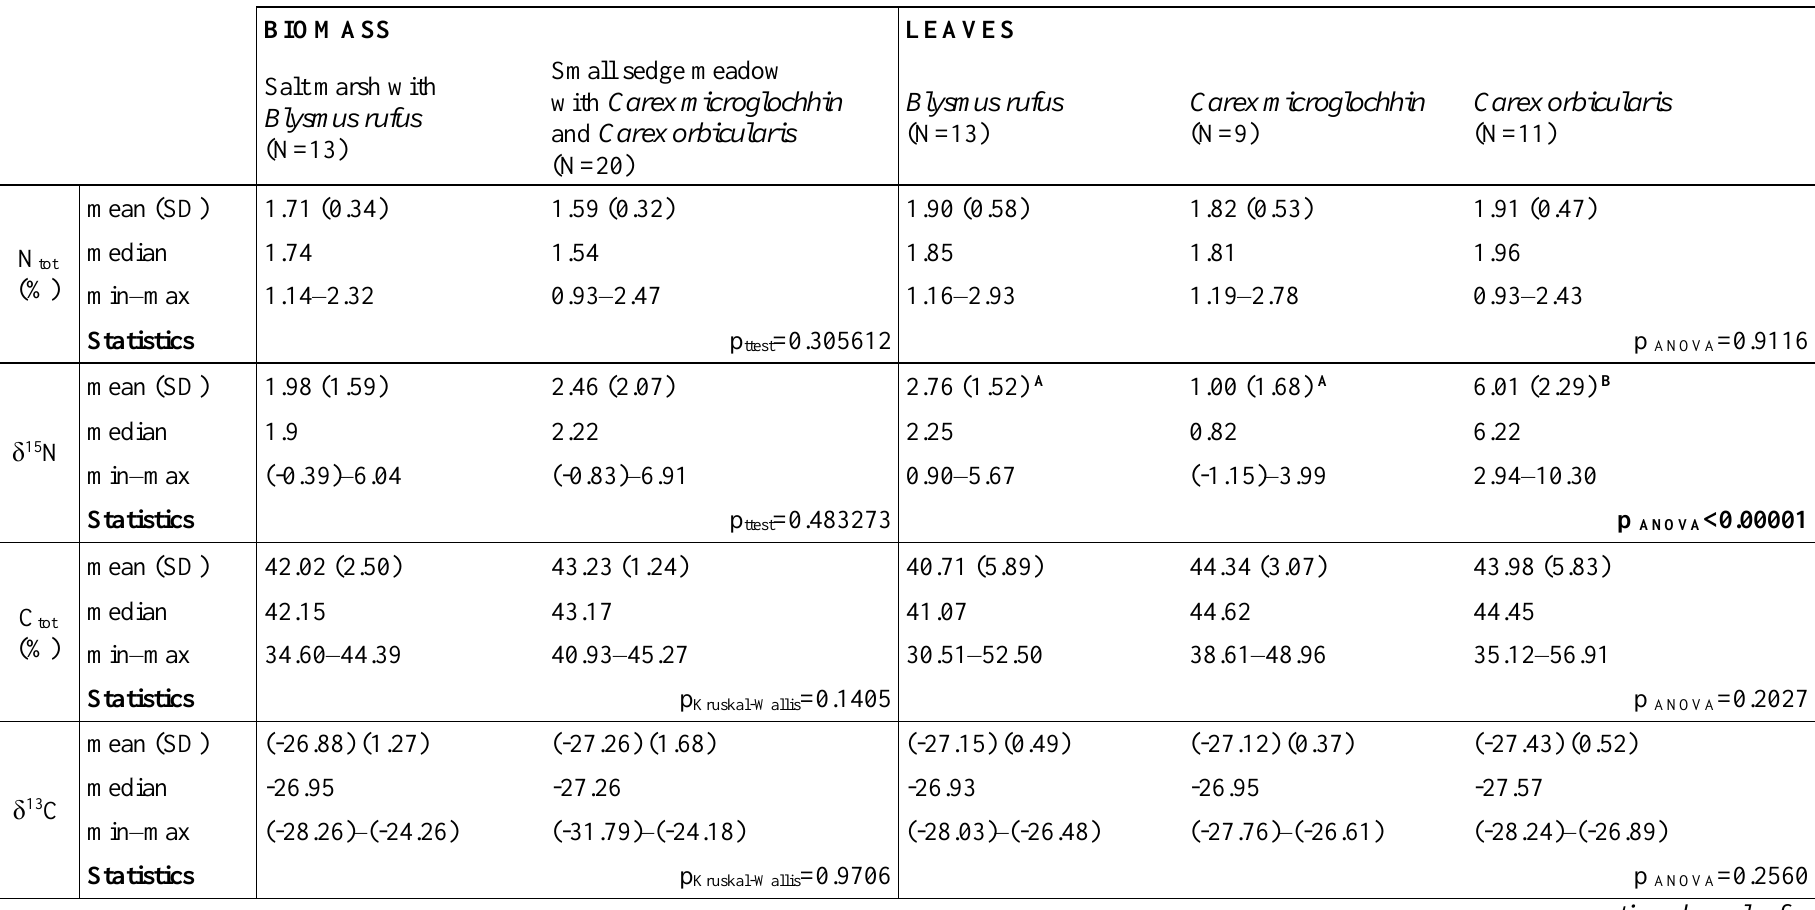
Table A1. CNP stoichiometry and isotopic composition of biomass from salt marsh with Blysmus rufus and from small sedge meadow with Carex species; and of leaves from three dominant species in these plant communities - Blysmus rufus , Carex microglochin and Carex orbicularis